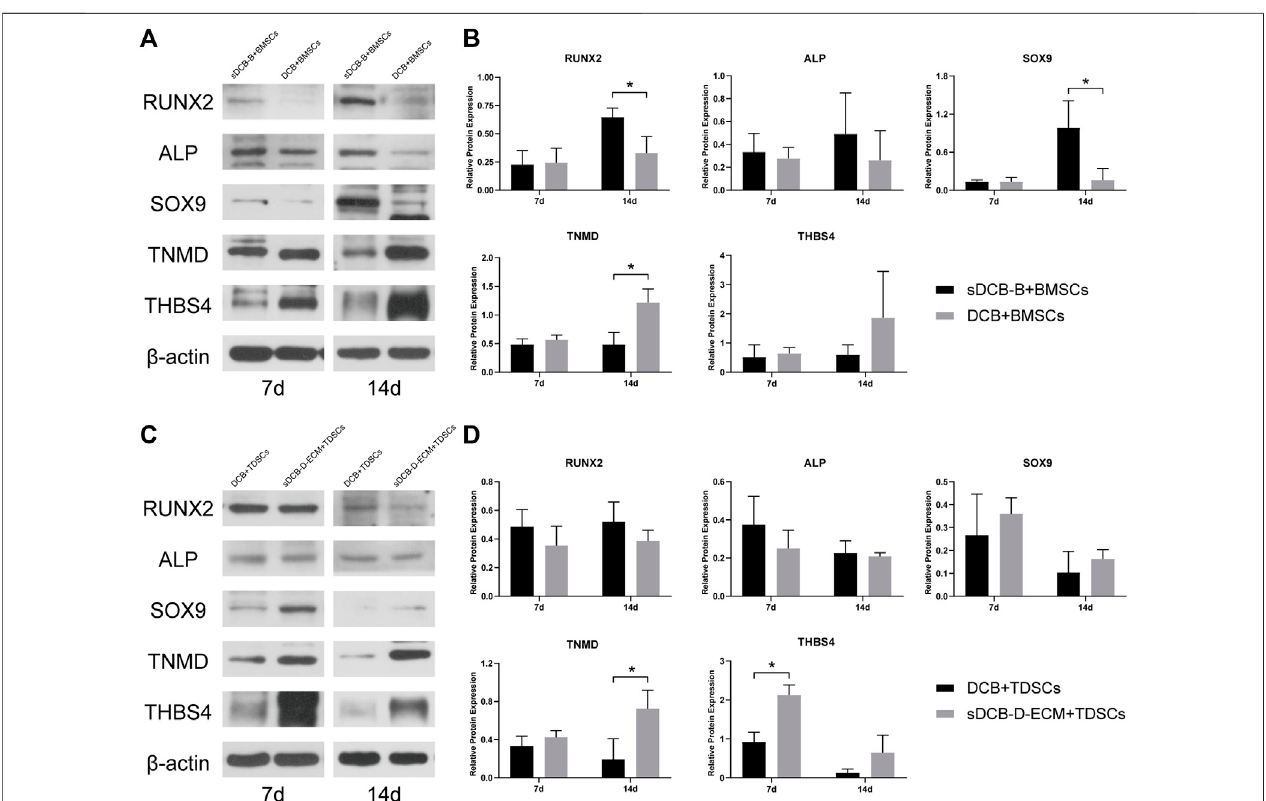
FIGURE8| WesternblotanalysisofrelativeproteinexpressionsinBMSCs (A,B) andTDSCs (C,D) at7and14 daysafterculturedonscaffolds.Thelevelsofprotein expression are normalized to β -actin. * Indicated p < 0.05.